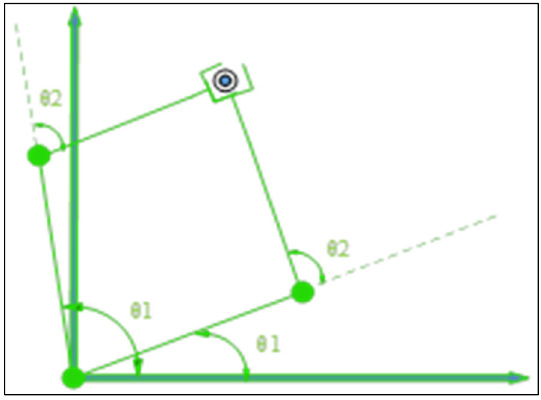
Fig. 2. The configurations of two-link arm elbow up and elbow